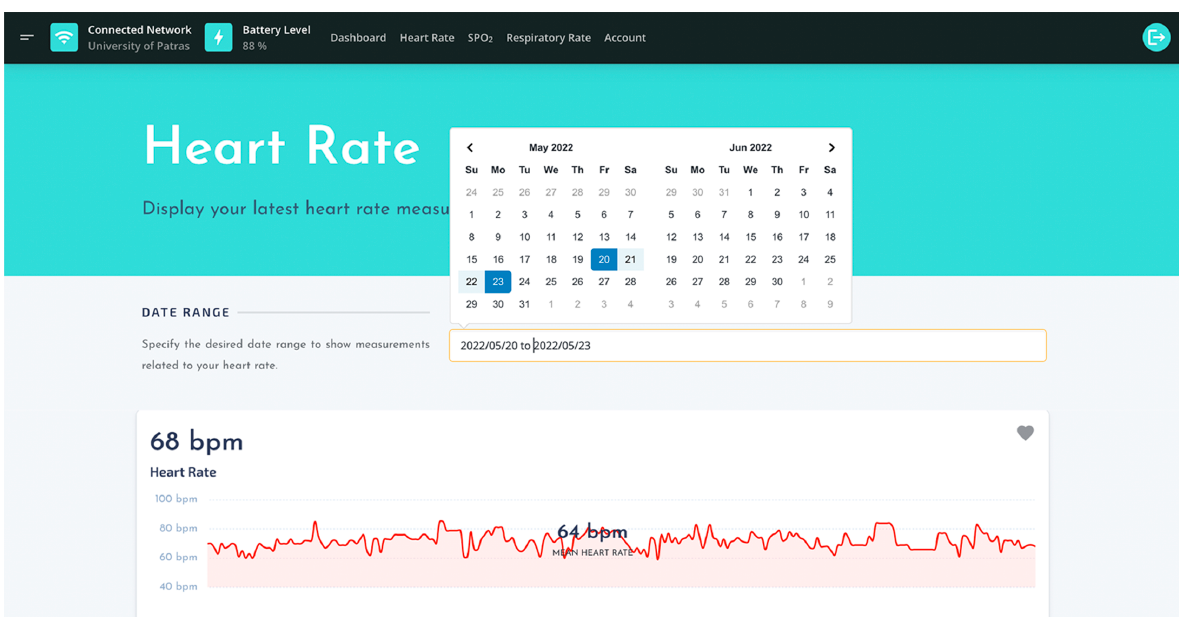
Figure 12. The UI of heart rate analytics.